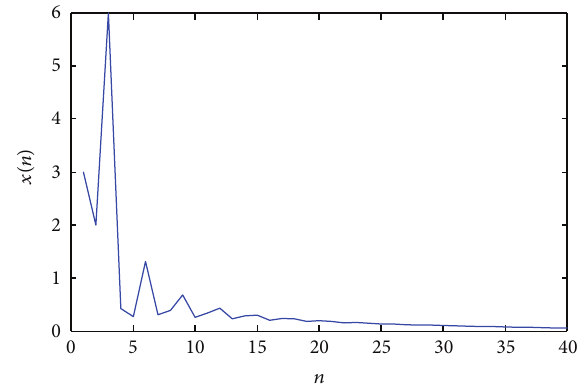
Figure 1: It shows the solution of (9) with 𝑙 = 1, 𝑘 = 2, 𝑥 −2 = = 2, 𝑥 = 6, 𝑎 = 2, 𝑏 = 5, 𝑐 = 8, and 𝑑 = 6 . 3, 𝑥 −1 0